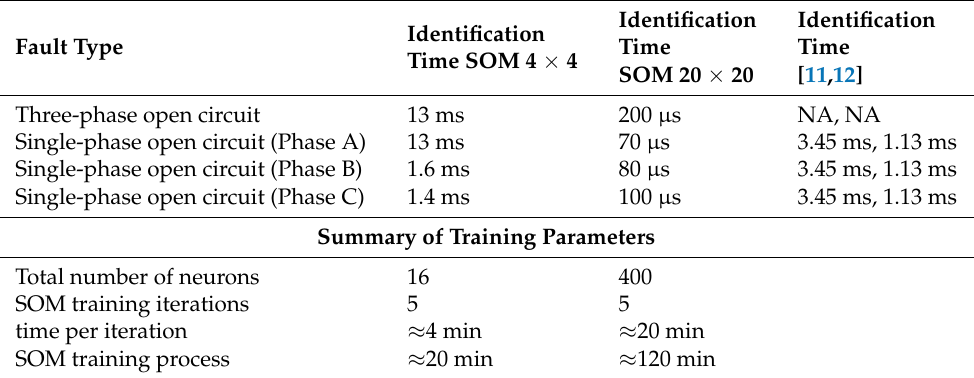
Table 7. Experimental results. Experimental Summary and Comparison for Open Circuit Fault